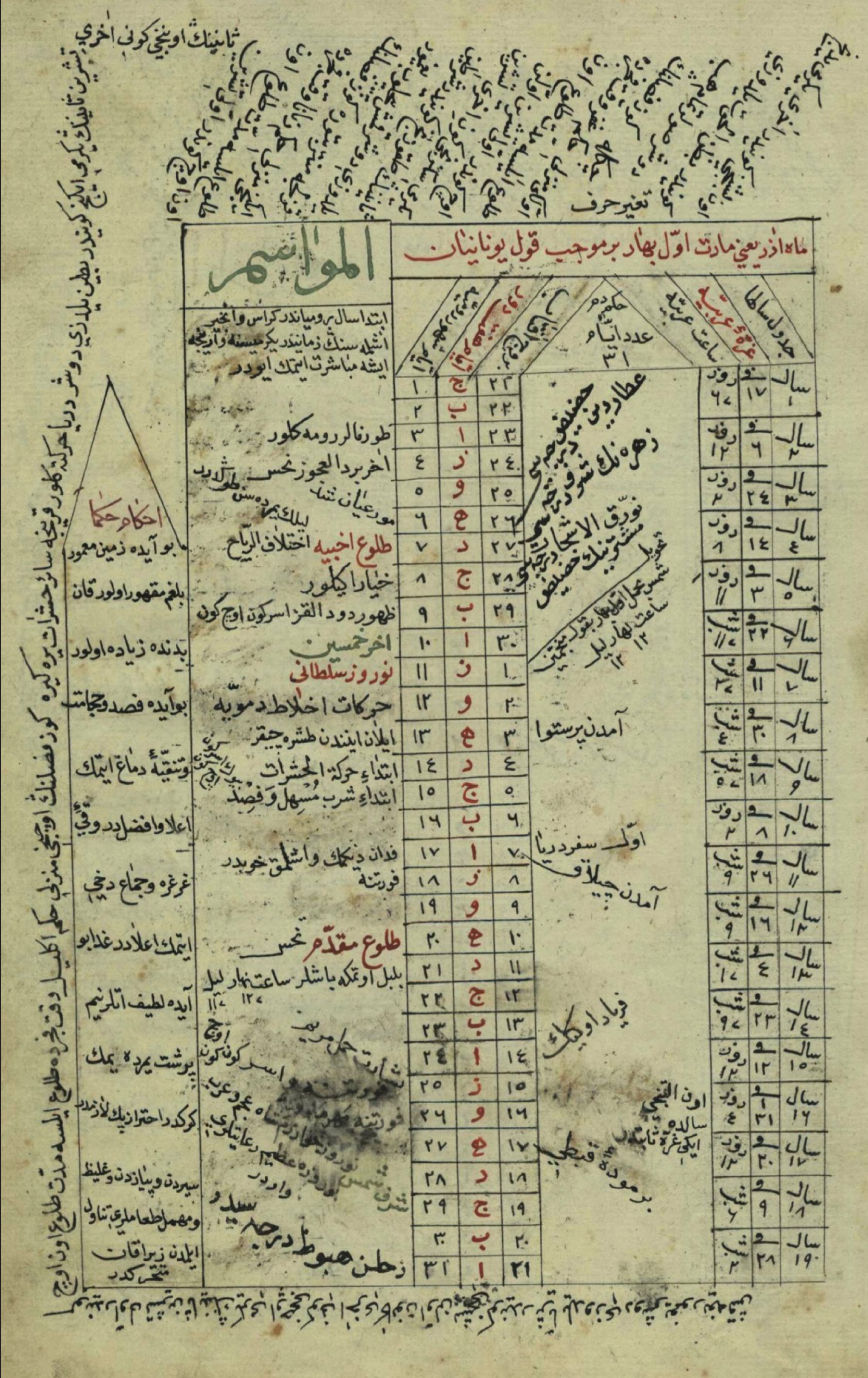
Figure 2: Anonymous Ruzname, Milli Yazmalar FB380, 13b. Image courtesy of Türkiye Yazma Eserler